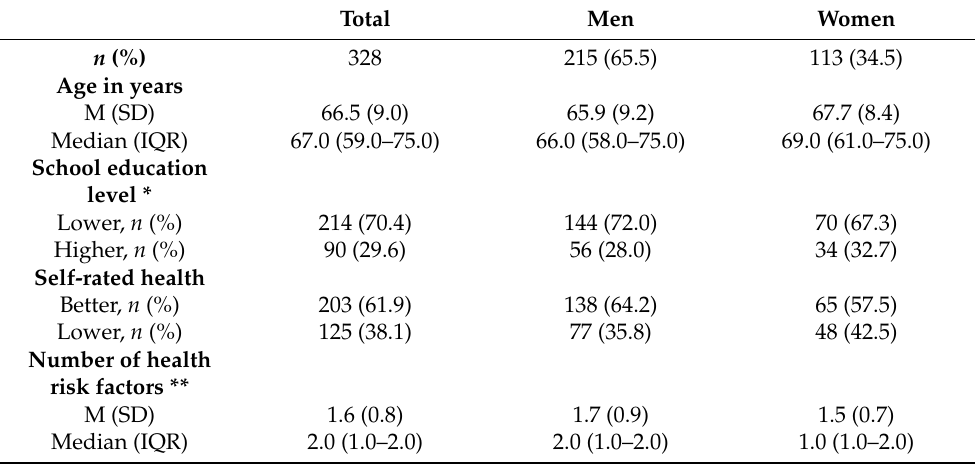
Table 1. Sociodemographic characteristics, self-rated health, and number of behavioral health risk factors (of the four health risk factors of overweight, inactivity, alcohol, and smoking) for the total sample and stratified by sex.